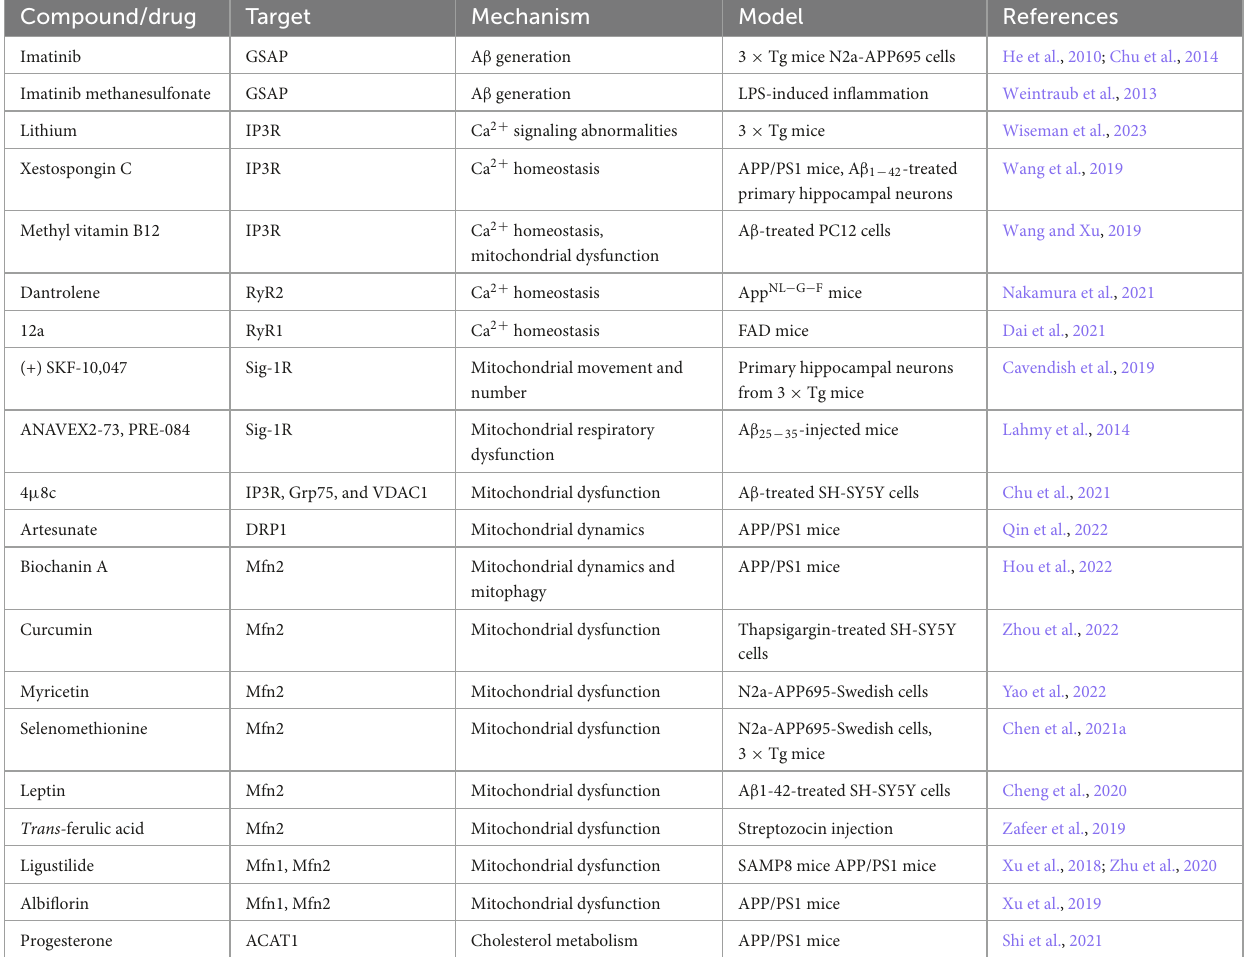
TABLE 1 Compounds and drugs targeting MAM tethering proteins for treating